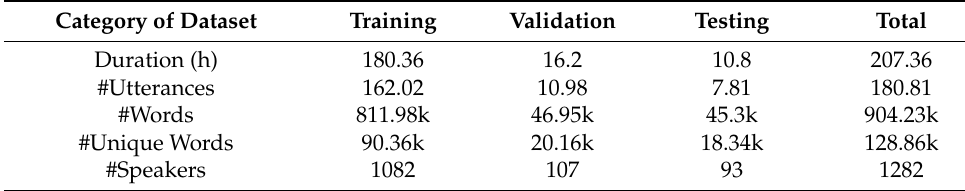
Table 3. Specifications of the Uzbek language corpus